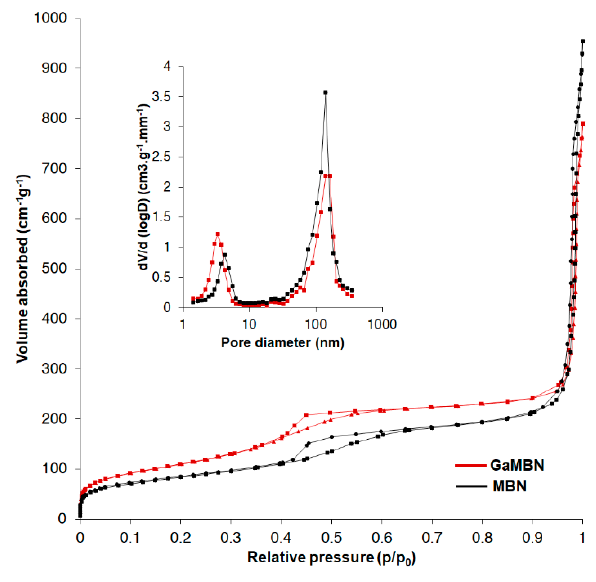
Figure 3. ( a ) FTIR and ( b ) XRD spectra of MBN and GaMBN.